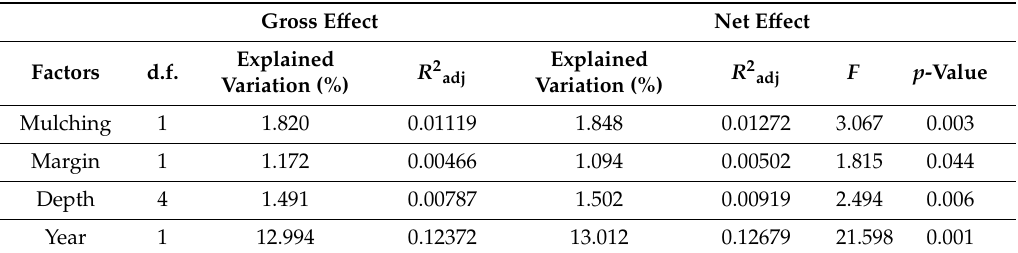
Table 5. Gross and net effects of explanatory variables on weed seed bank in an open-field tomato experiment identified using redundancy analysis (RDA) with single explanatory variables (Gödöll ő , Hungary, 2016–2018).